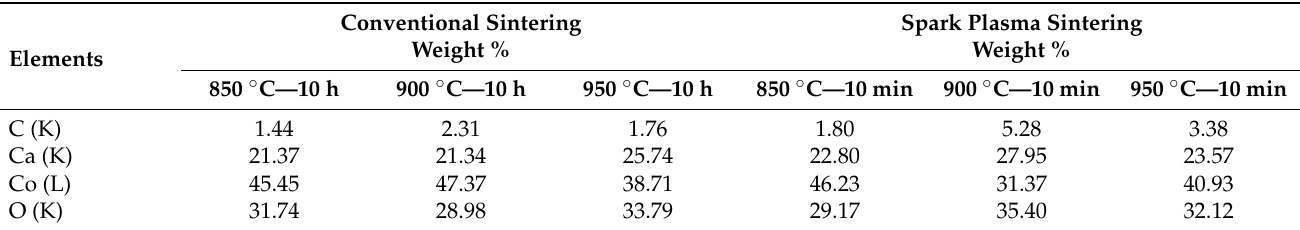
Figure 4. SEM images of bulk samples sintered at ( a ) CS-850, ( b ) CS-900, ( c ) CS-950, ( d ) SPS-850, ( e ) SPS-900, and ( f ) SPS-950.